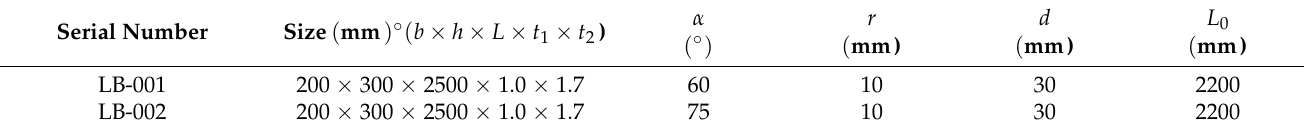
Table 3. Model parameters of composite